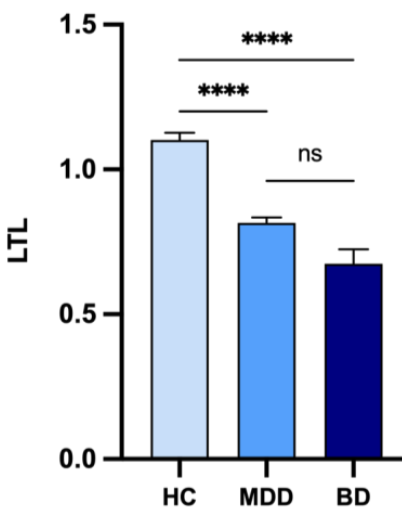
Figure 3. LTL in patients with treatment-resistant depression stratified based on diagnosis and controls. Barplots showing mean and standard error of the mean. **** p < 0.0001. Abbreviations: BD, bipolar disorder; HC, controls; MDD, major depressive disorder; ns, not significant.